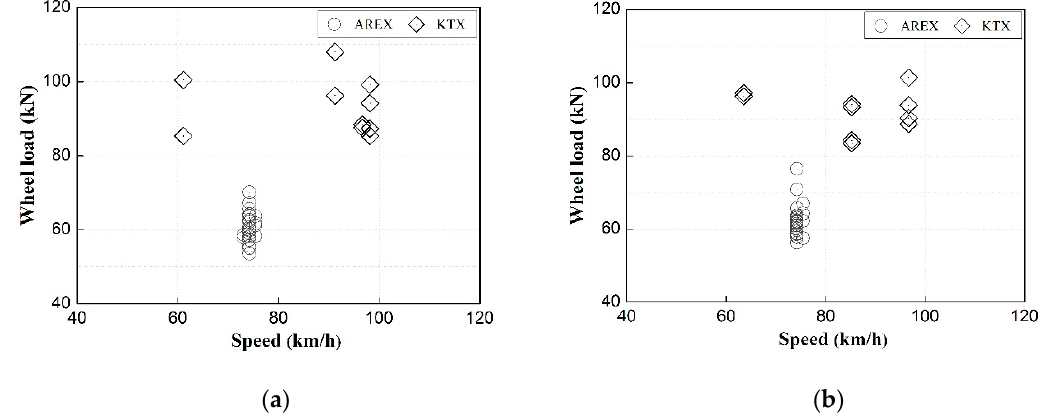
Figure 4. Measured dynamic wheel load by train type. (a) Before rail pad replacement and (b) after rail pad replacement.